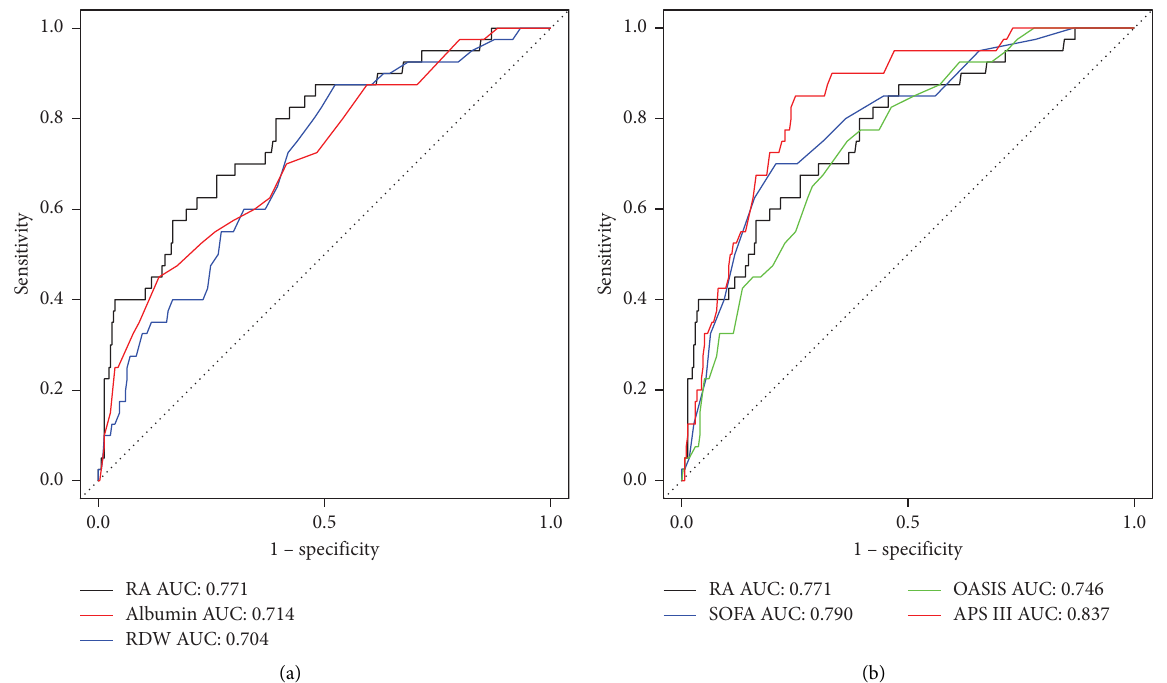
Figure 1: ROC curves. (a) ROC curves for the RA, RDW, and albumin. (b) ROC curves for the RA, SOFA, OASIS, and APS III. In both fgures, RA had higher AUC values than RDW and albumin. Te AUC value of RA is lower than SOFA and APS III but higher than OASIS. ROC, receiver operating characteristic; RA, red blood cell distribution width-albumin ratio; SOFA, sequential organ failure assessment; OASIS, Oxford acute disease severity score; APS III, acute physiology score